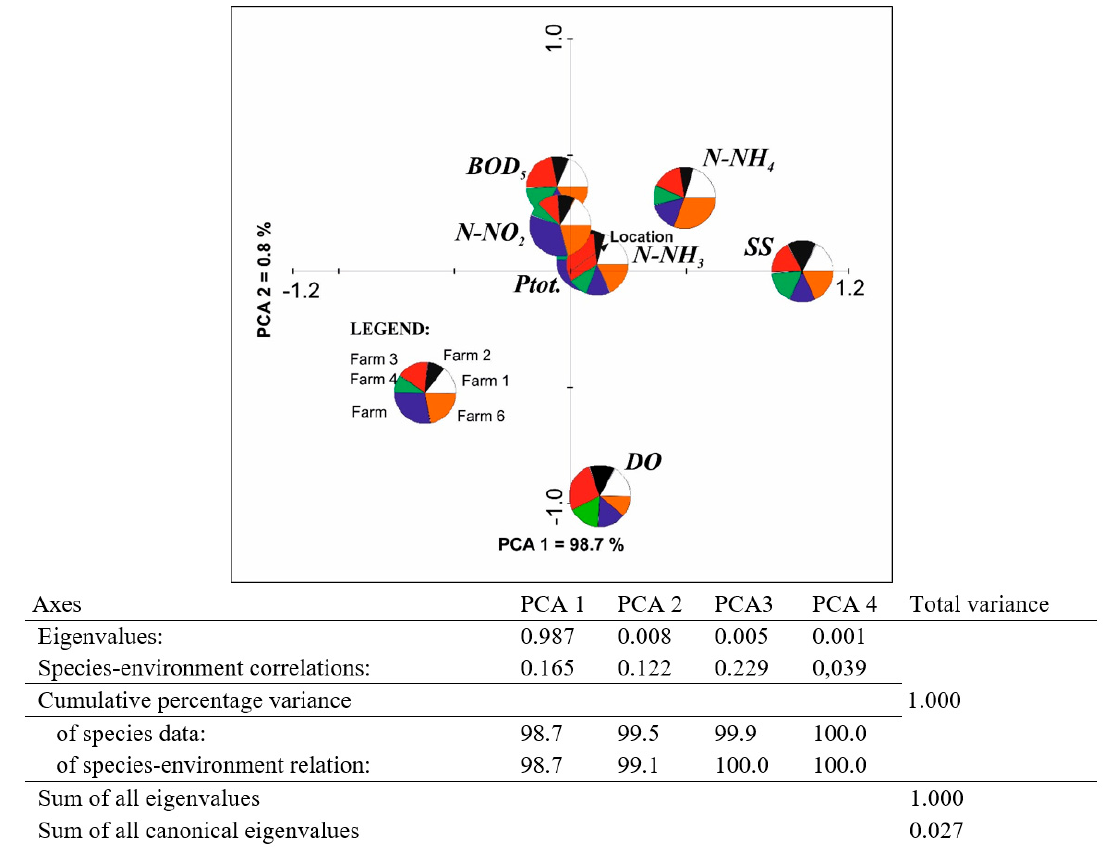
Figure 2. Principal component analysis (PCA) of correlations between concentrations of selected substances in waters inflowing to trout ponds.